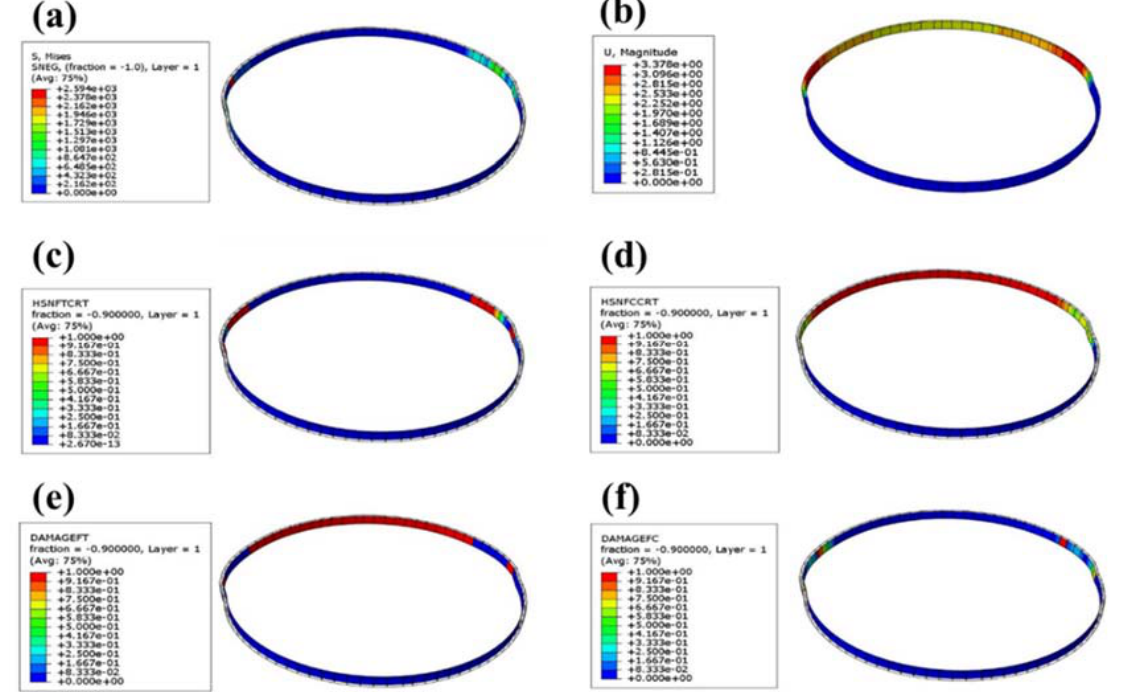
Figure 4. Cloud diagram of progressive failure of composite NOL ring: ( a ) Mises stress cloud diagram of NOL ring; ( b ) tensile deformation cloud diagram of NOL ring; ( c ) initial tensile failure cloud diagram of fiber layer; ( d ) initial compressive failure of fiber layer; ( e ) evolution cloud diagram of tensile damage of fiber layer; ( f ) evolution cloud diagram of compression damage of fiber layer.